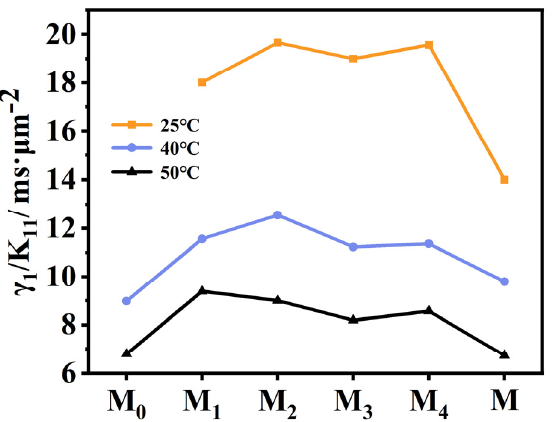
Figure 7. The viscoelastic constants of LC mixtures at 25 °C, 40 °C and 50 °C.